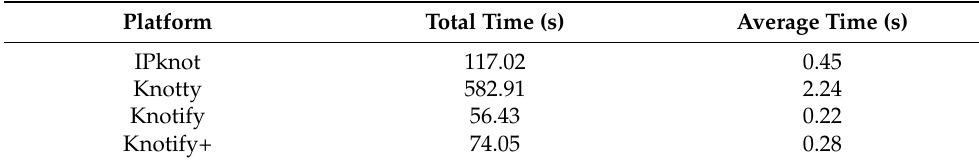
Table 5. The execution time required for each method in the whole